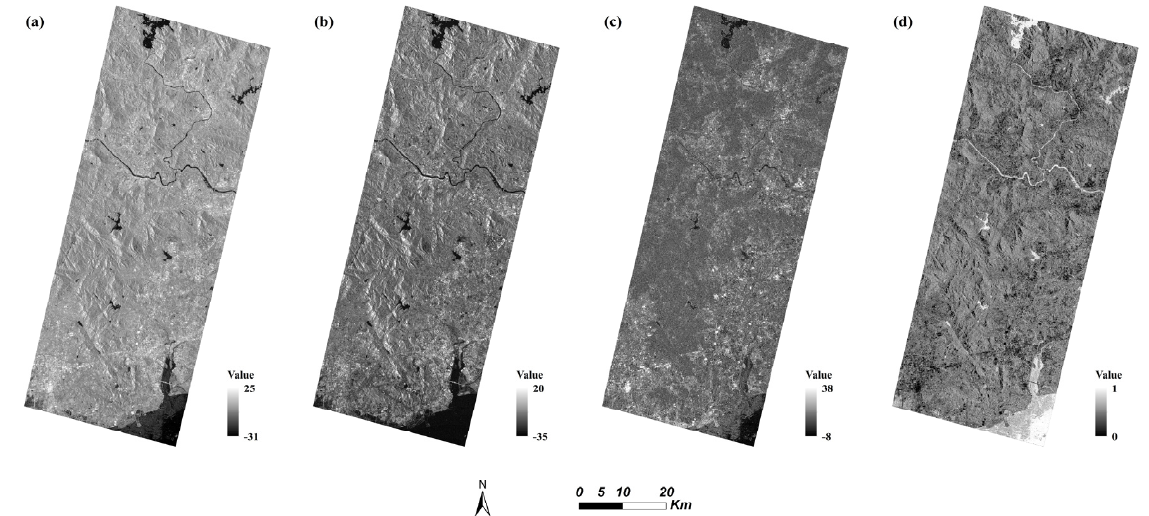
Figure 7. Polarimetric feature map of the study area from Sentinel-1 image: ( a ) VV band, ( b ) VH band, ( c ) VV-VH, ( d ) VV/VH.